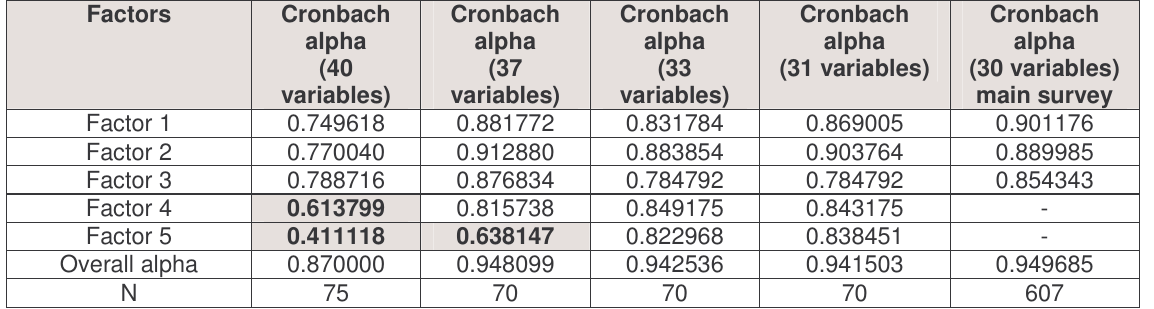
Table 2: Reliability Values Factors